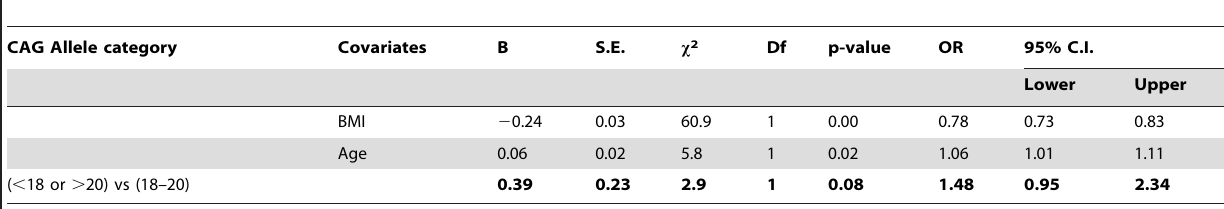
Table 4. Odds ratio for the CAG allele categories ( , 18 or . 20) VS (18–20) in the entire case cohort versus controls taking age and BMI as covariates.